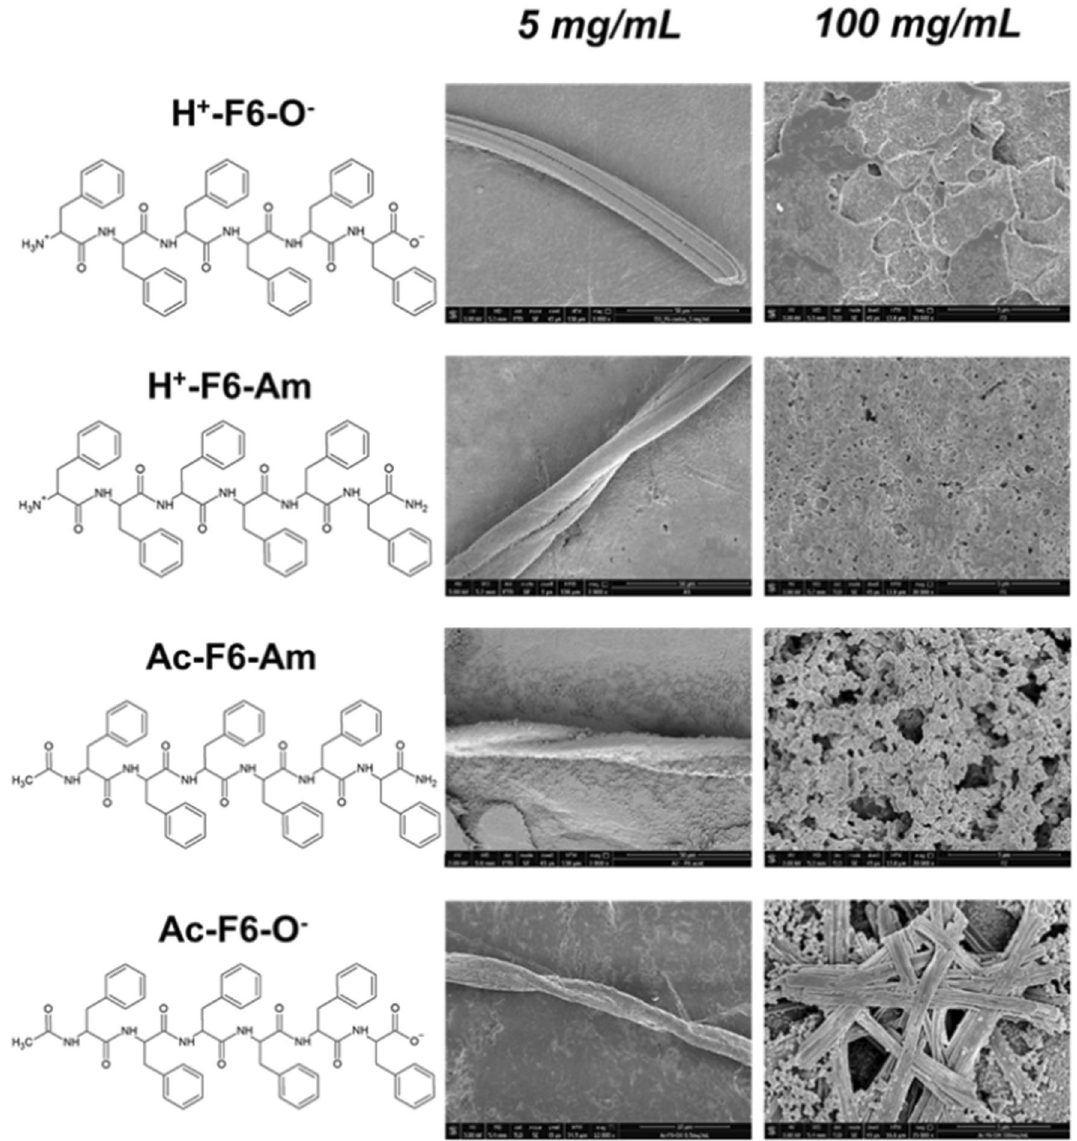
Figure 1. Schematic representation of F6-peptide variants; selected SEM micrographs for peptides at 5.0 and 100 mg/mL (50 mg/mL for H + -F6-O − ); the scale bars are 50 μm and 5 μm,